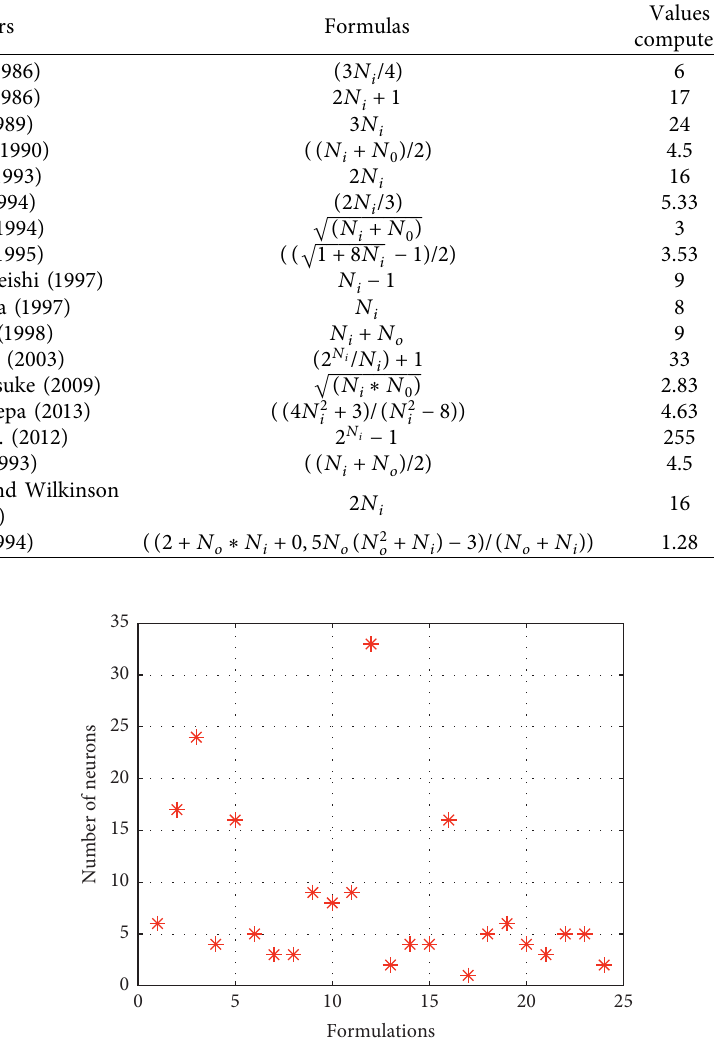
Figure 5: Calculation of neuron number using different formulations proposed in the literature. Table 3: Summary of different ANN characteristics used in this